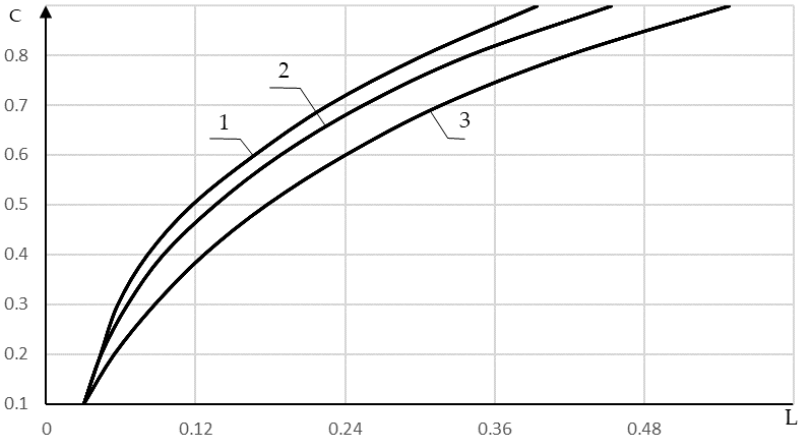
Figure 3. Dependence of dimensionless stress c at the crack tip c on the dimensionless moment L : 1 of z = 0.1; 2 of z = 0.2; 3 of z = 0.3.